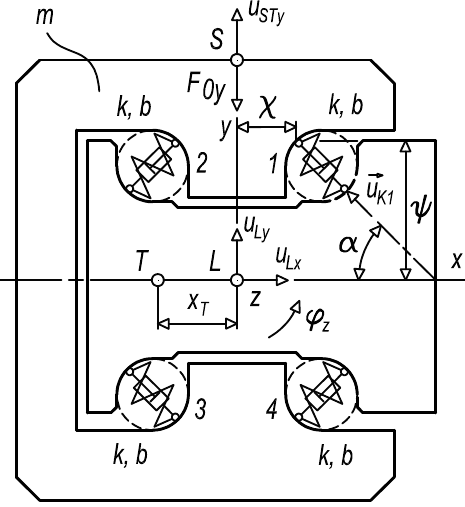
Figure 10. The mechanical model of the diagnostic part.